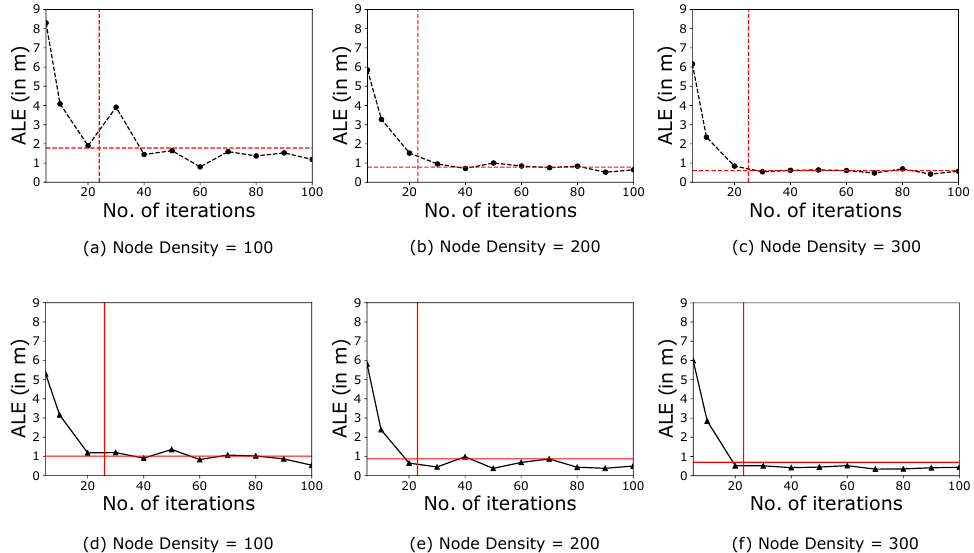
Figure 5. Variation of ALE with respect to the number of iterations for a transmission range of 15 m over a monitoring area of 100 m × 100 m.